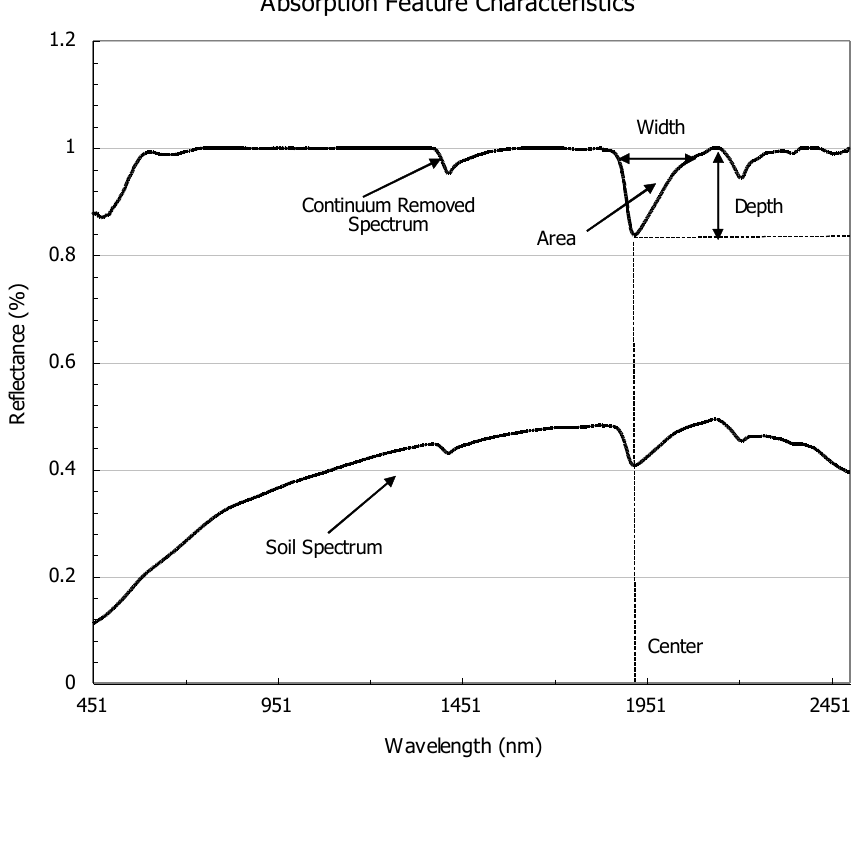
Figure 1. Original spectra and continuum removed spectra showing absorption feature parameters: absorption-band depth, width, center and